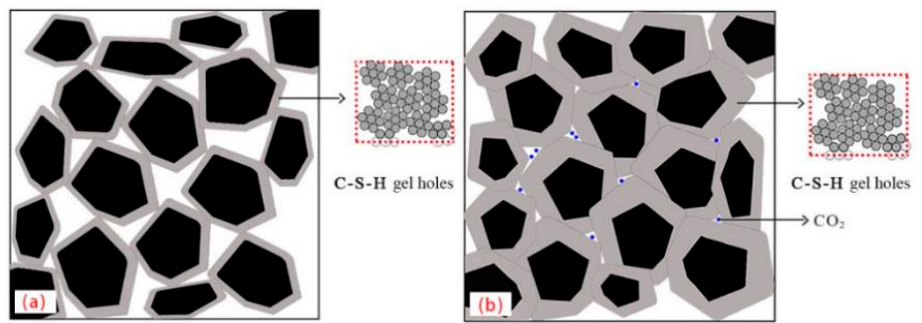
Figure 15. Carbonation mechanism of ultrasonic vibration agitation forming. ( a ) Non ‐ invaded CO 2 ; ( b ) Invasion of CO 2